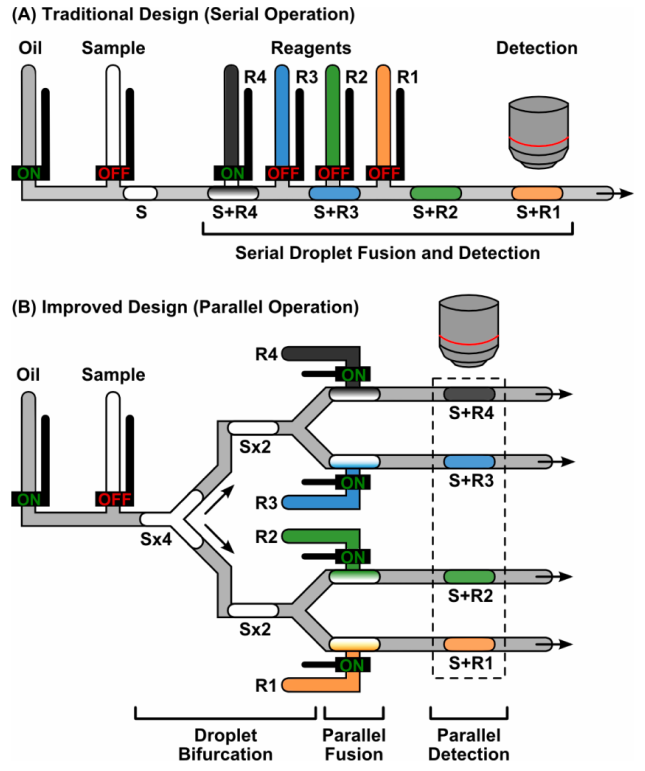
Figure 1. Improving Throughput of Combinatorial Droplet Devices via Parallelization. ( A ) In the traditional design, sample droplets (S) are fused with designated reagents (R1–R4) one at a time to generate the train of combinatorial droplets (S + R1, etc. ), which maintain their spatial index within the single channel before they are sequentially optically detected. ( B ) The current design leverages parallelized operation via droplet bifurcation, parallel reagent injection, and parallel detection to improve the throughput. Specifically, each sample droplet first travels through bifurcating Y-junctions (two stages, as shown here) and split into identical daughter droplets (four, as shown here) before each daughter droplet is fused with its designated reagent via direct injection. Importantly, the reagents can be simultaneously injected into the daughter droplets, thereby facilitating improved throughput. Finally, detection of fused droplets can be performed one group at a time, further ensuring high-throughput operation within the device. To address this limitation, we have developed a parallelized combinatorial droplet device design. This design is achieved via droplet splitting [30–36], parallelized droplet fusion, and parallelized droplet detection (Figure 1B). Specifically, each sample droplet first travels through bifurcating Y-junctions (two stages, as shown here) and split into identical daughter droplets (four, as shown here) before each daughter droplet is fused with its designated reagent. Importantly, the reagents can be simultaneously injected into the daughter droplets, thereby facilitating improved throughput. Finally, the entire group of fused sample-reagent droplets originating from the single sample droplet can be detected in parallel, further enhancing the throughput. To demonstrate this